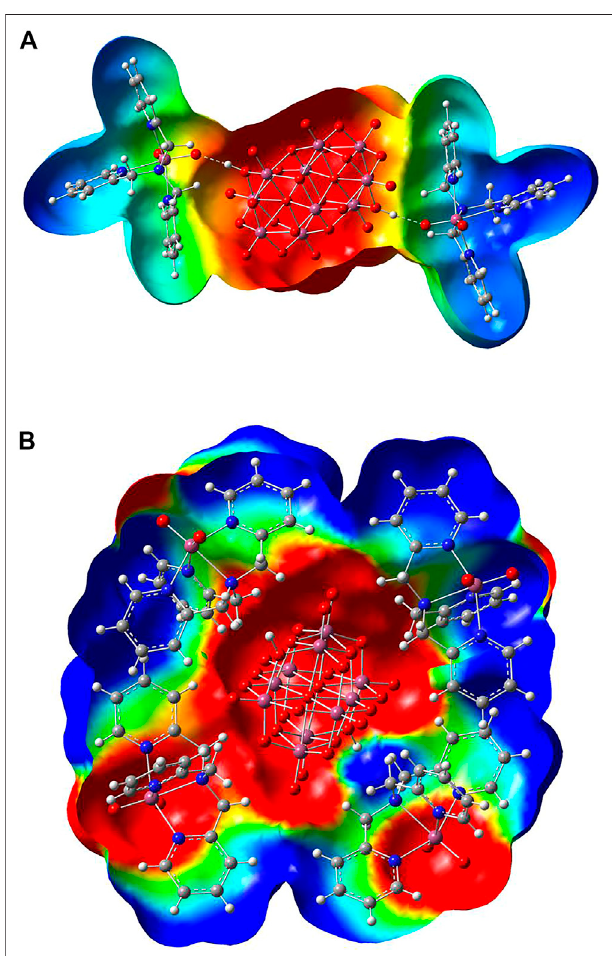
FIGURE 6 | Molecular electrostatic potential map of (A) the representation of Compound 1 forming hydrogen bonds connecting both species of V(V), and (B) the asymmetric unit showing to the diprotonated decavanadate unit and four dioxidovanadium(V)-tpma moieties, calculated at the theory level mPW1PW91/6 – 31G(d)-LANL2DZ using ECP = LANL2DZ for the V atom.